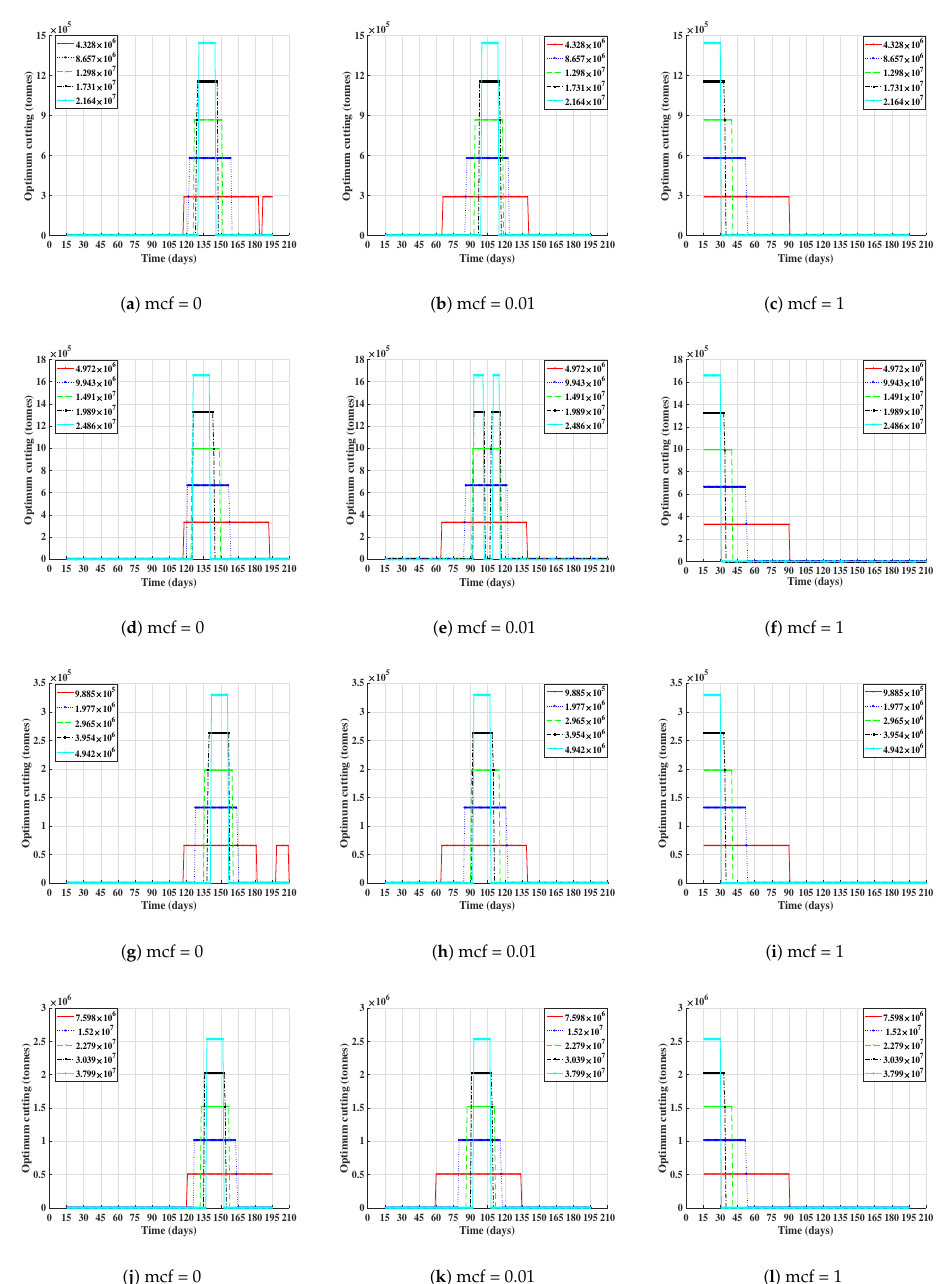
Figure 2. Optimum cutting of fired sugarcane in four regions of Thailand in year 2017/18 showing effects of changing maintenance cost by fraction mcf of actual cost. North: ( a – c ), Central: ( d – f ), East: ( g – i ), North-east: ( j – l